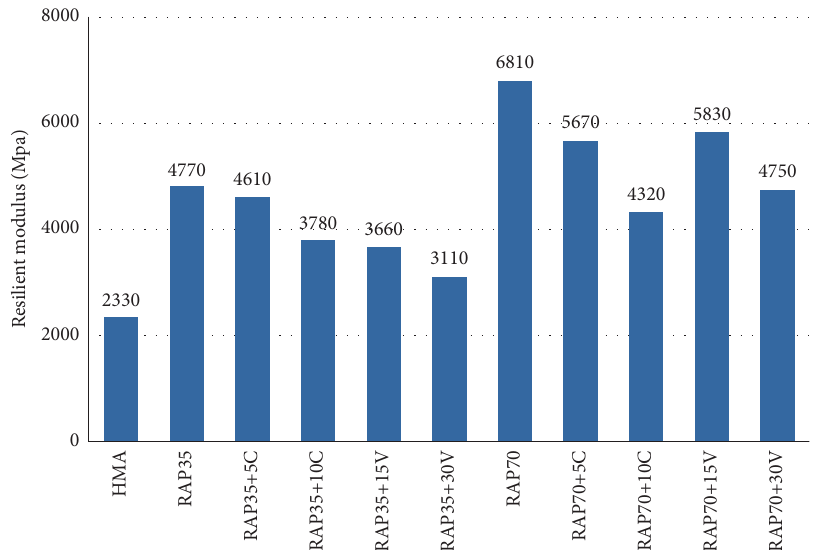
Figure 2: Efect of RAP and rejuvenating agents on the resilient modulus of asphalt